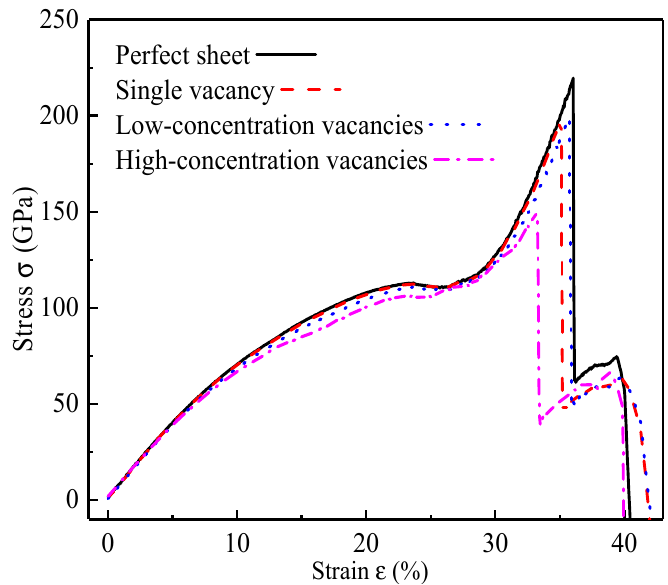
Figure 2. Tensile stress-strain curves of SLGSs with different vacancy